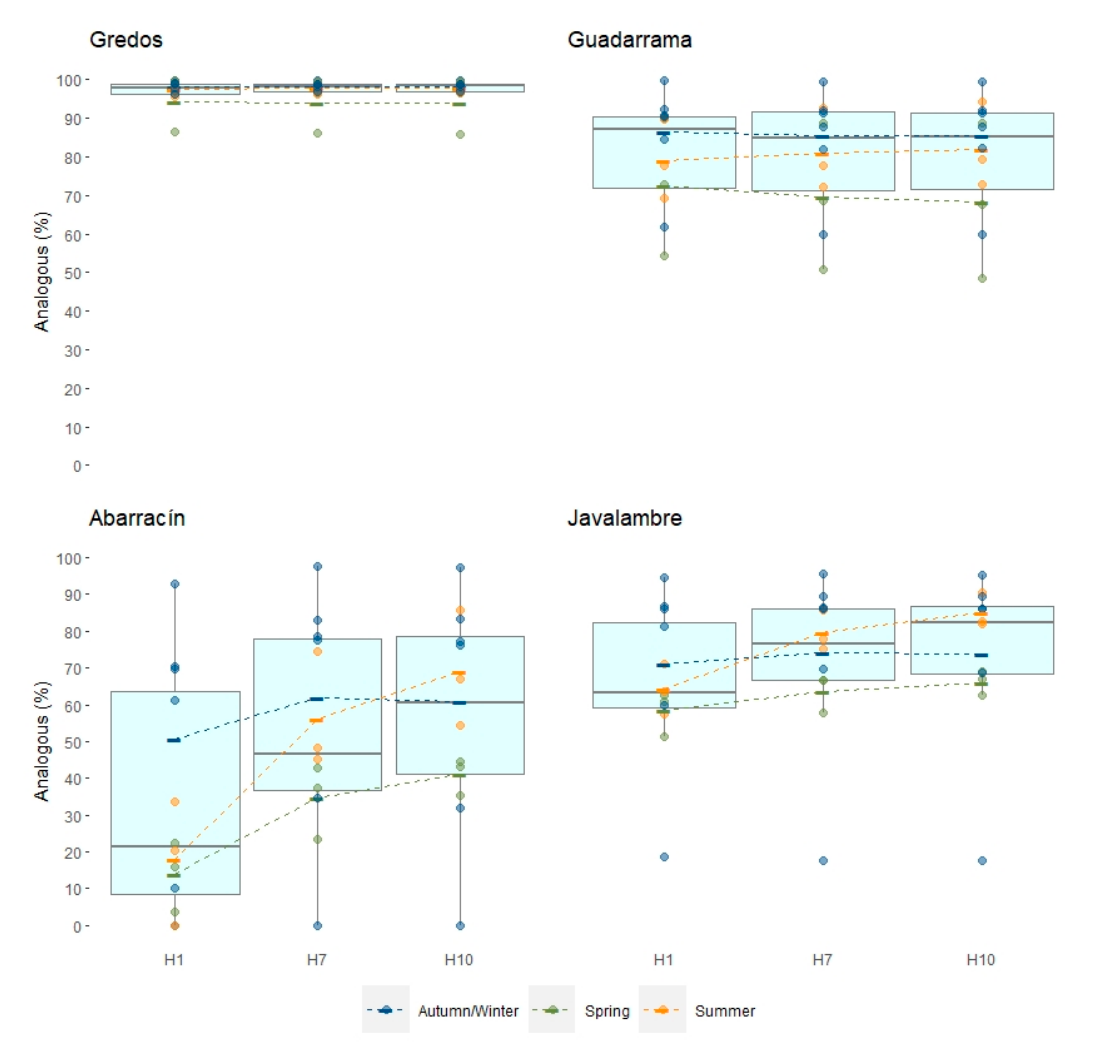
Figure 6. The percentage of 30 m pixels showing analogous modelled microclimate temperatures from 1980 ‐ 89 to 2010 ‐ 19 for three reference habitat types in the four focal mountain 6 × 6 km cells. Each panel shows one region, with data grouped by habitat type: pine forests “H1”, scrublands “H7” and grasslands “H10”. Coloured bars show mean for each season and habitat; habitats joined in each region by dotted lines. Box plots show median and interquartile range across all months in each habitat type. Table 2. Generalized linear model for the proportion of analogous monthly maximum temperatures between 1980 ‐ 89 and 2010 ‐ 19 for modelled microclimate in three reference habitat types: H1 (pine forest), H7 (open scrubland), H10 (short grassland). Reference categories are Region—Gredos; Hab ‐ itat—H1—pine forest; Season—Autumn/Winter. The best model was selected based on a quasibi ‐ nomial error term using quasi Akaike information criterion (QAIC). QAIC of null model = 281.55, QAIC of model shown = 142.39, QAIC of next ‐ best model = 144.14.